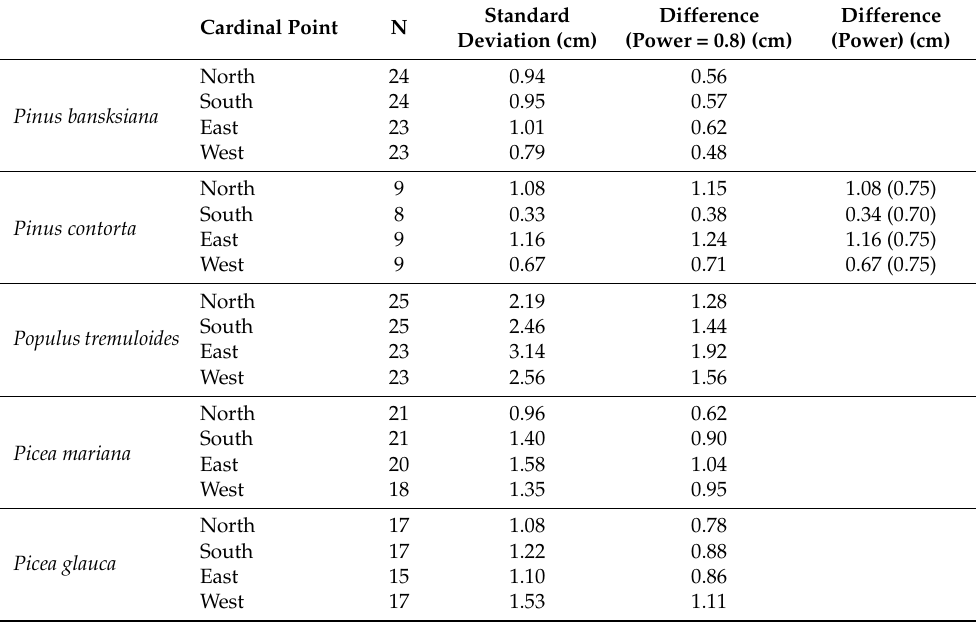
Table 2. Detectable difference in significance tests for a Power (1- β ) of 0.8 and α = 0.05. N is the total number of wood cores, and the furthest column on the right reports the difference for the Power shown in